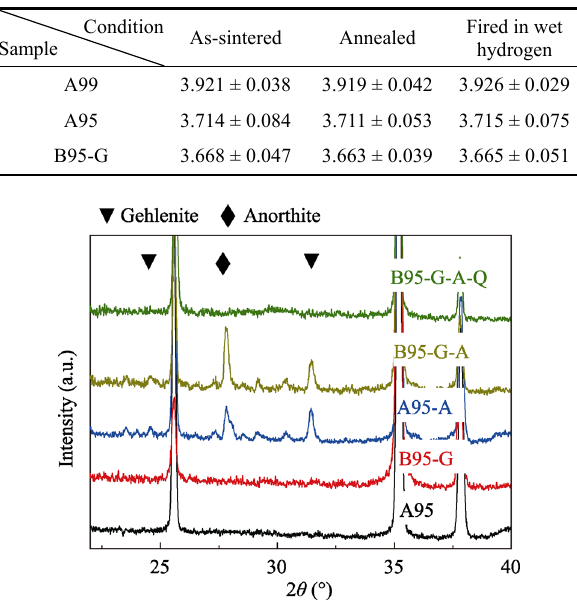
Fig. 3 XRD patterns of 95% alumina ceramics before and after annealing and